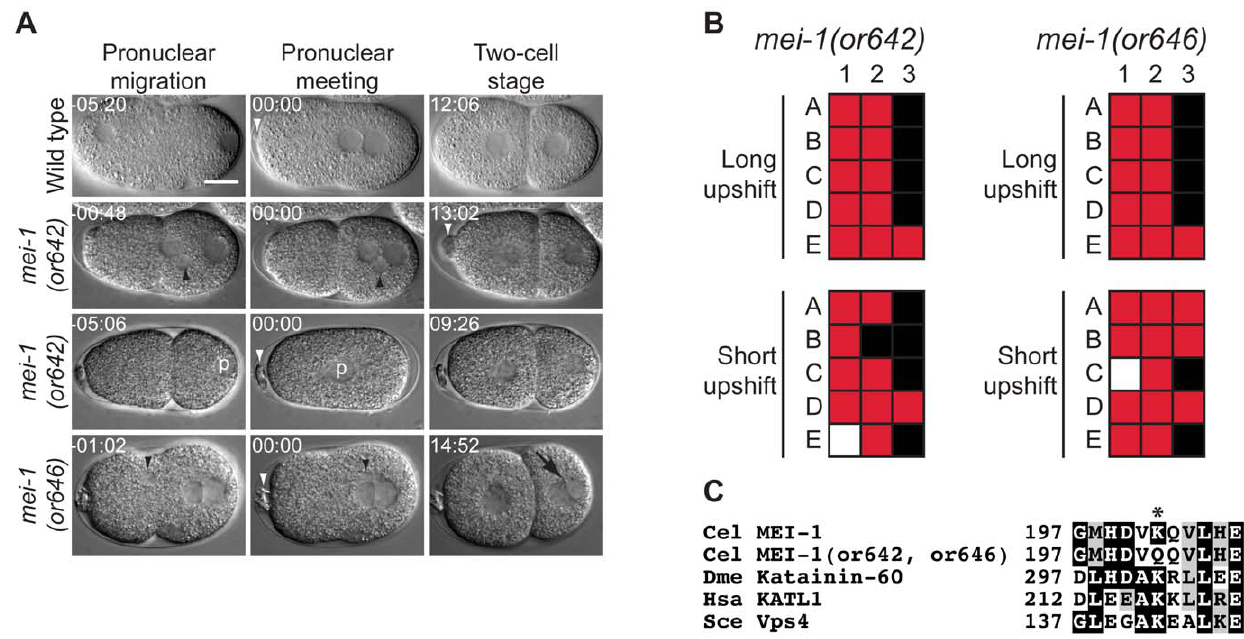
Figure 5. mei-1 mutants. A. DIC time-lapse images of wild-type, mei-1(or642 ts ) and mei-1(or646 ts ) embryos. In the mei-1 mutants the polar bodies were large and misshapen and embryos contained multiple [top mei-1(or642 ts ) embryo and mei-1(or646 ts ) ] or zero maternal pronuclei (second mei- 1(or642 ts ) embryo). The two mei-1(or642 ts ) embryos were obtained from a hermaphrodite shifted to the restrictive temperature for 30 minutes, the mei-1(or646 ts ) embryo was obtained from a hermaphrodite shifted to the restrictive temperature for 7 hours prior to imaging. White arrowheads indicates polar bodies, black arrowheads indicate multiple maternal pronuclei, the black arrow denotes multiple nuclei per cell at the two cell stage, and the ‘‘p’’ refers to the paternal pronucleus in an embryo lacking a maternal pronucleus. Times in min:sec are given relative to nuclear envelope breakdown (NEBD). Scale bar, 10 m m. B. Defect maps of individual embryos observed during time-lapse recordings: embryos are listed on the left and phenotypes are listed on the top: 1; normal polar body size, 2; normal pronuclear number, 3; one nucleus per cell at two cell stage. In the long upshifts, hermaphrodites were transferred to the restrictive temperature for 5–8 hours. In the short upshifts, embryos were harvested from hermaphrodites grown at the restrictive temperature for 30 minutes. C. Amino acid alteration in the mutants. Asterisk indicates the changed residue. Homologous proteins are aligned below the C. elegans protein.